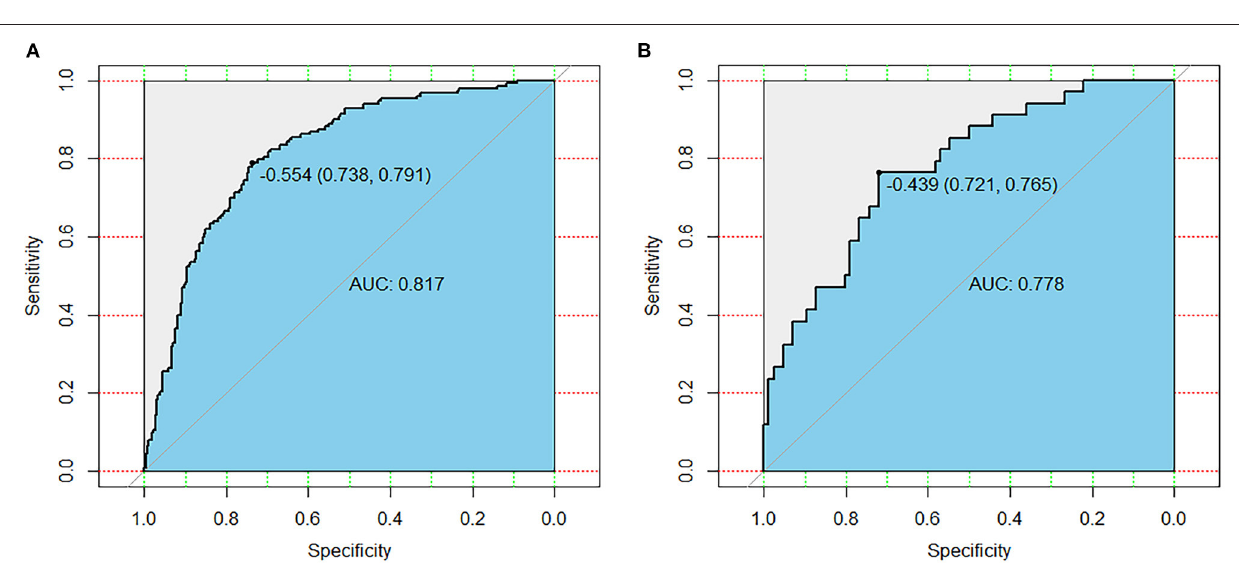
FIGURE 3 | Receiver operating characteristic curves of the primary cohort (A) and validation cohort (B) . AUC, area under the receiver operating characteristic